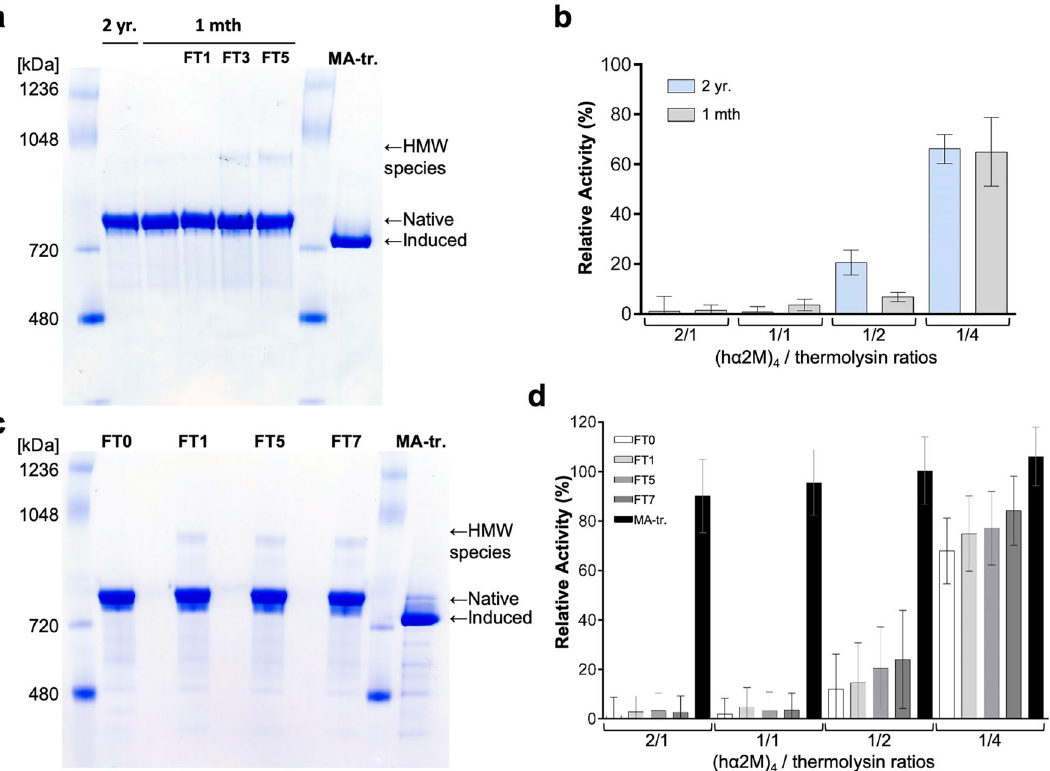
Figure 3. Effect of long-term storage and freezing/thawing of native hα 2 M. ( a , c ) Native PAGE analysis of native hα 2 M from FR samples stored for (a) 1 month or 2 years or ( c ) 3 months at – 30 °C. Native hα 2 M samples were further subjected to seven fast ( a ) or slow ( b ) freeze–thaw cycles (FTx). This procedure causes the emergence of high-molecular-weight (HMW) species, as previously reported for protein stored for several months at 4 °C 39 . MA-treated hα 2 M was used as a control for induced hα 2 M. ( b , d ) Inhibition of thermolysin activity against the fluorescent substrate BODIPY FL-casein by ( b ) hα 2 M from FR samples stored for 1 month or 2 years at – 30